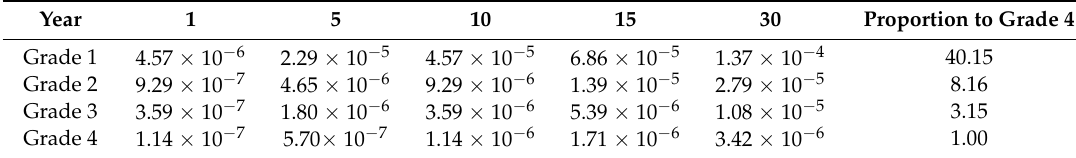
Table 6. The estimated average probability of landslide occurrence over time